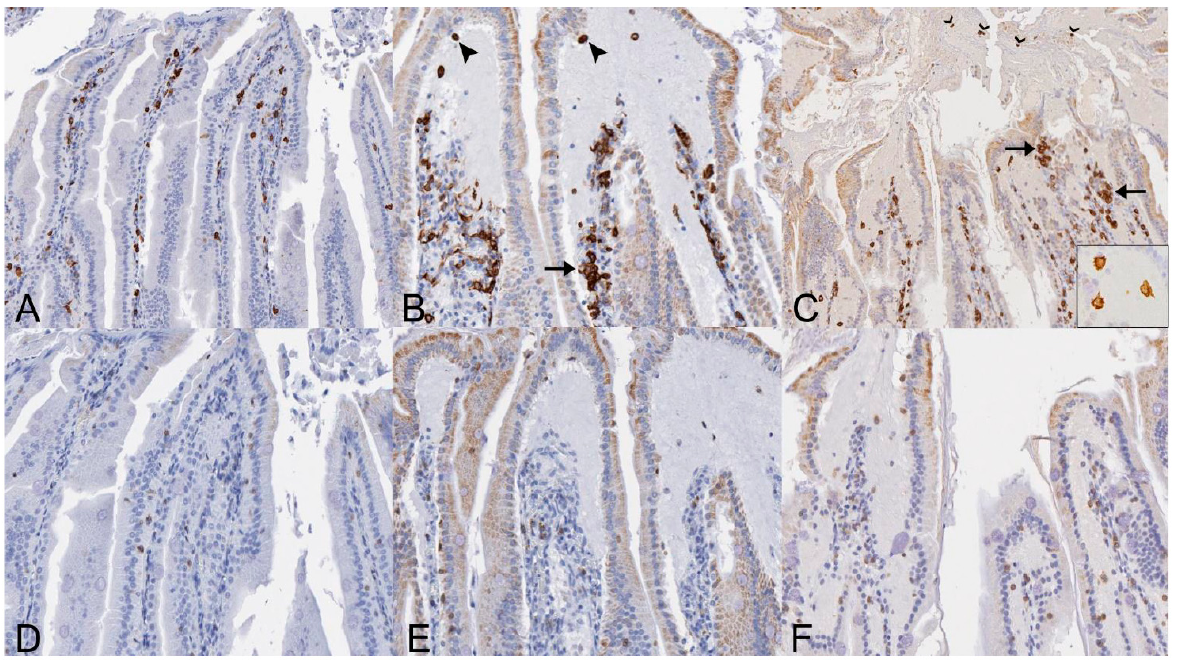
Figure 6. Distribution of Iba1- and CD3-immunolabeled cells in the small intestines of SOSV-infected Egyptian rousette bats euthanized at 9 and 21 DPI. ( A ) Iba1 immunohistochemistry (IHC), jejunum, control bat 290195. Iba1-immunolabeled cells (brown) are present in moderate numbers throughout the lamina propria core of the small intestinal villi. Original magnification = 200×. ( B ) Iba1 IHC, jejunum, 9 DPI bat 287756. Moderate numbers of Iba1-immunolabeled cells are present within the lamina propria core, occasionally in small clusters (arrow). Low numbers of Iba1+ cells with an amoeboid morphology are scattered within the lamina propria fluid and just beneath the epithelium at the villus tip (arrowheads). The small intestines of this bat had the highest viral load of all tissues tested during the serial sacrifice study. Original magnification = 200×. ( C ) Iba1 IHC , jejunum, 21 DPI bat 289953. The villus core and lamina propria contain moderate numbers of Iba1+ cells, occasionally clumped in small aggregates (arrows). Several villus tips have epithelial defects through which fluid spills from the lamina propria into the lumen. This luminal fluid contains several Iba1+ cells (open arrowheads). Inset: Higher magnification image demonstrating the amoeboid phenotype of macrophages present within the lamina propria fluid. This bat intermittently shed SOSV in the feces throughout the duration of the serial euthanasia study. Original magnifications = 100× (main image) and 600× (inset). ( D ) CD3 IHC, jejunum, control bat 290195 . Low numbers of CD3+ cells (brown) are scattered throughout the epithelium. Rare CD3+ cells are present within the lamina propria core. Original magnification = 400×. ( E ) CD3 IHC, jejunum, 9 DPI bat 287756. Low numbers of CD3+ cells are scattered throughout the intestinal epithelium and occasionally present within the lamina propria fluid. Slightly increased CD3+ cells are present within the lamina propria core compared to the control. Original magnification = 400×. ( F ) CD3 IHC, jejunum, 21 DPI bat 289953. Scattered CD3+ cells are present just beneath the intestinal epithelium and within the lamina propria fluid. Slightly increased numbers of CD3+ cells are distributed throughout the lamina propria core compared to the control. Original magnification = 400×. All immunohistochemical stains were performed using 3-3 ′ -Diaminobenzidine (DAB; brown) chromogen to visualize cellular antigen and hematoxylin counterstain.